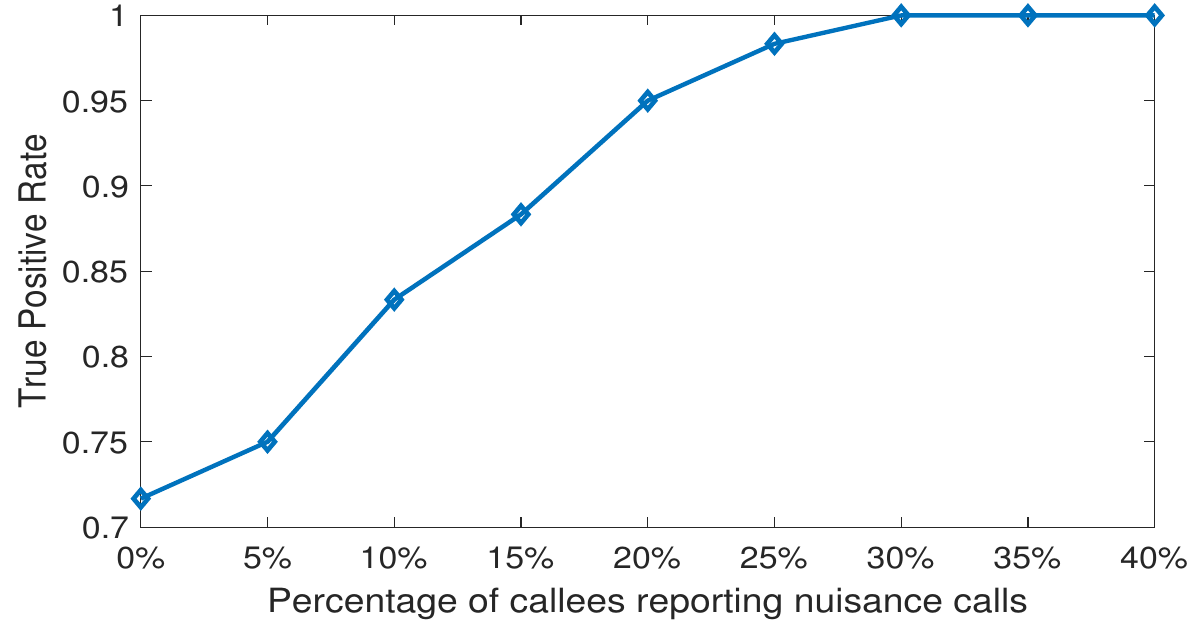
Figure 8. Performance in terms of